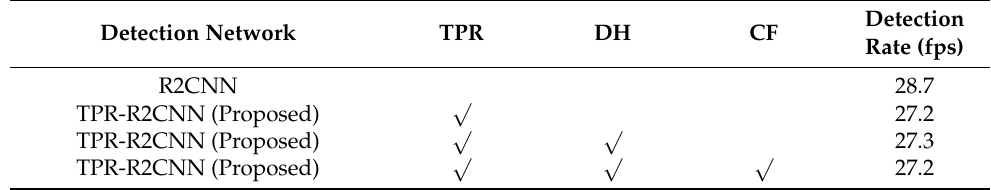
Table 4. Comparison of detection rate (fps) on DOTA-v1.5 dataset. TPR: Three-point regression; DH: double detection head; CF: classification fusion.